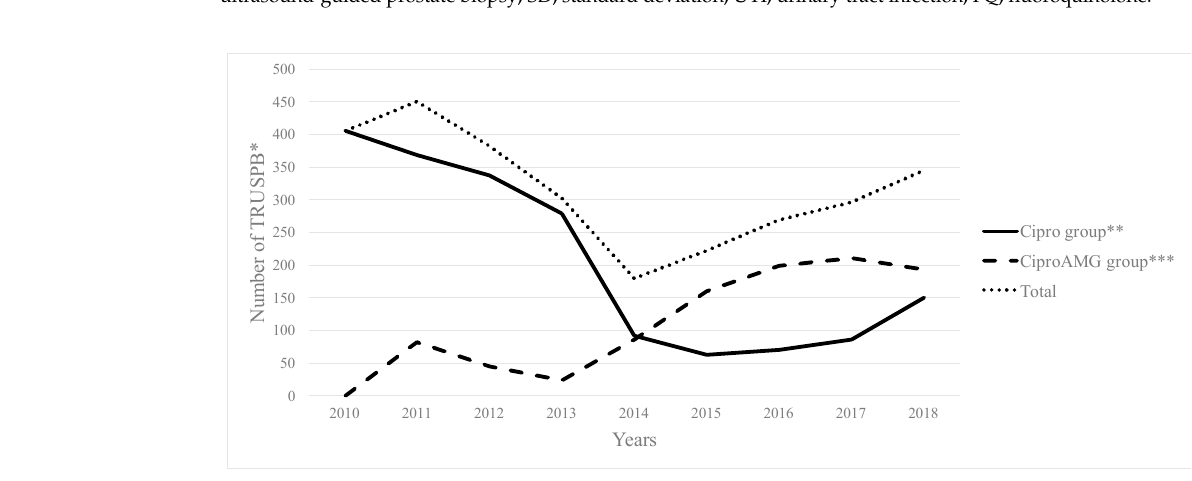
Figure 1. Number of transrectal ultrasound-guided prostate biopsies performed from 2010 to 2018. The number of transrectal ultrasound-guided prostate biopsies per year are shown in a linear trend and are stratified according to groups (Cipro group and CiproAMG group) and total number of biopsies performed. * Transrectal ultrasound-guided prostate biopsy. ** Significant negative trend. *** Significant positive trend.